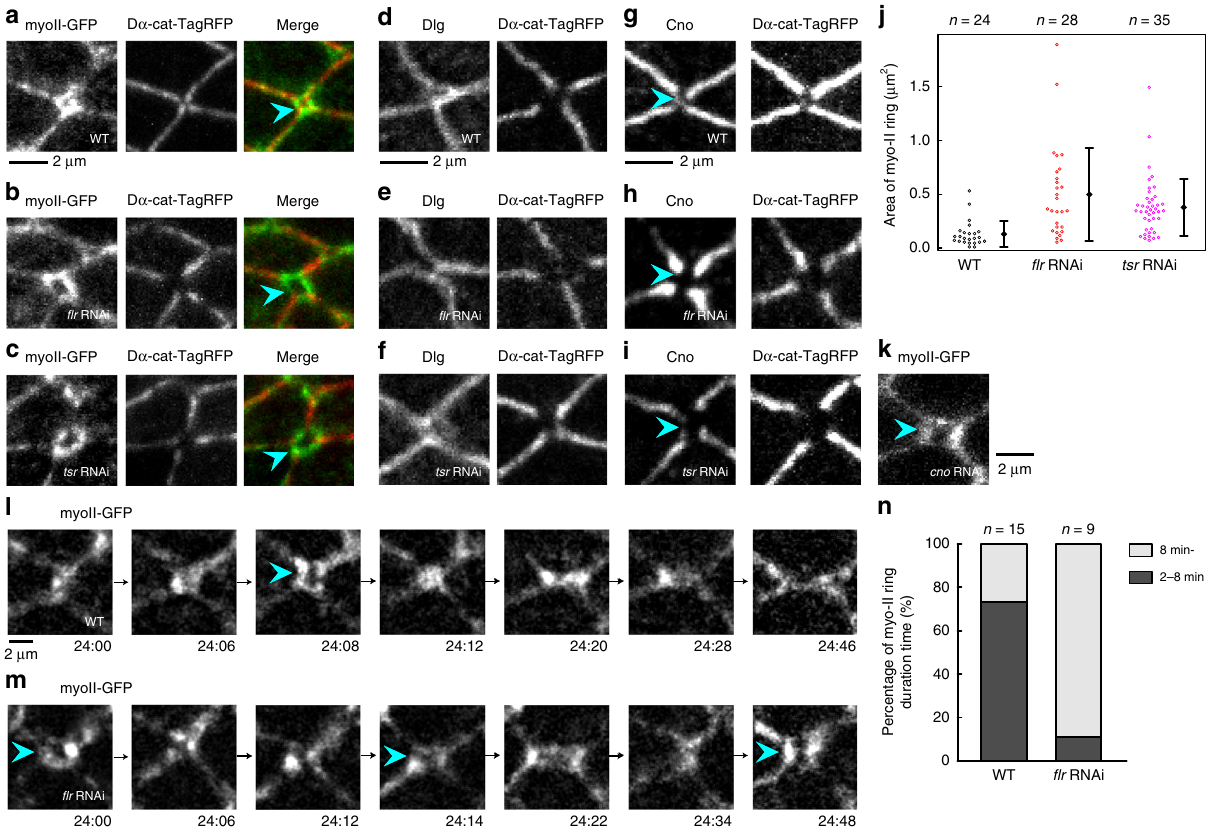
Fig. 6 fl r or tsr RNAi disrupts the Cno-mediated linkage between actomyosin and the AJ in remodeling junctions. a Images of myo-II-GFP (gray in a left panel, green in a right panel) and D α -cat-TagRFP (gray in a middle panel, red in a right panel) in a WT wing at 24 h APF. The blue arrowhead indicates a “ myo-II ring ” along the short remodeling junction. b , c Images of myo-II-GFP (gray in left panels, green in right panels) and D α -cat-TagRFP (gray in middle panels, red in right panels) in a fl r RNAi wing at 24 h APF ( b ) and a tsr RNAi wing at 20.5 h APF at 29 °C, which corresponds to ~24 h APF at 25 °C ( c ). myo-II rings were enlarged in RNAi cells (blue arrowheads). d – f Images of a SJ marker, Dlg (left), and D α -cat-TagRFP (right) in WT ( d ), fl r RNAi ( e ), and tsr RNAi ( f ) wings. The stages examined are described in a – c . Dlg was present in short junctions where D α -cat-TagRFP signals were faint. g – i Images of Cno (left) and D α -cat-TagRFP (right) in WT ( g ), fl r RNAi ( h ), and tsr RNAi ( i ) wings. The stages examined are described in a – c . fl r or tsr RNAi resulted in the loss of Cno from short junctions (blue arrowheads). j The myo-II ring area is plotted for each genotype. Steel test: WT vs. fl r RNAi, P < 0.001, WT vs. tsr RNAi, P < 0.001. The differences between WT and RNAi groups were statistically signi fi cant after excluding outliers above 1.2 µ m 2 . k An image of myo-II- GFP in a cno RNAi wing at 24 h APF. cno RNAi induced the detachment of junctional actomyosin (blue arrowhead). l , m Time-lapse images of myo-II-GFP in WT ( l ) and fl r RNAi ( m ) wings. Blue arrowheads indicate myo-II rings. The myo-II rings were not converted into stable PD junctions in fl r RNAi cells. Note that GFP signal intensity was modi fi ed via image processing; thus, we only tracked structural changes in these images. n The fraction of myo-II ring time duration for each genotype. The number of ROIs examined ( j ), and the number of events examined ( n ) are indicated. Data are presented as the mean ± s.d. ( j ). Scale bars: 2 µ m ( a , d , g , k , l